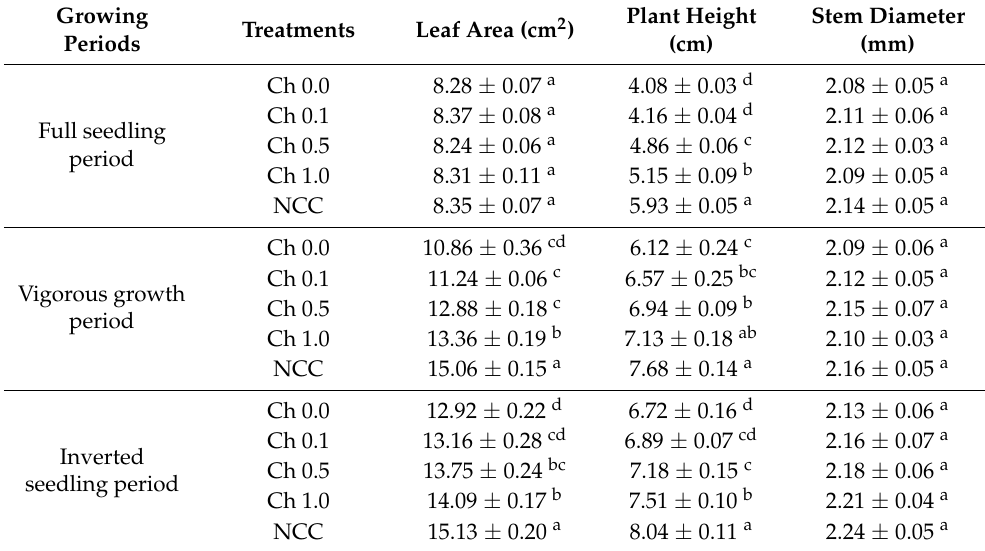
Table 1. The influences of chitosan spraying on the leaf area, height, and stem diameter of P. ternata plants.